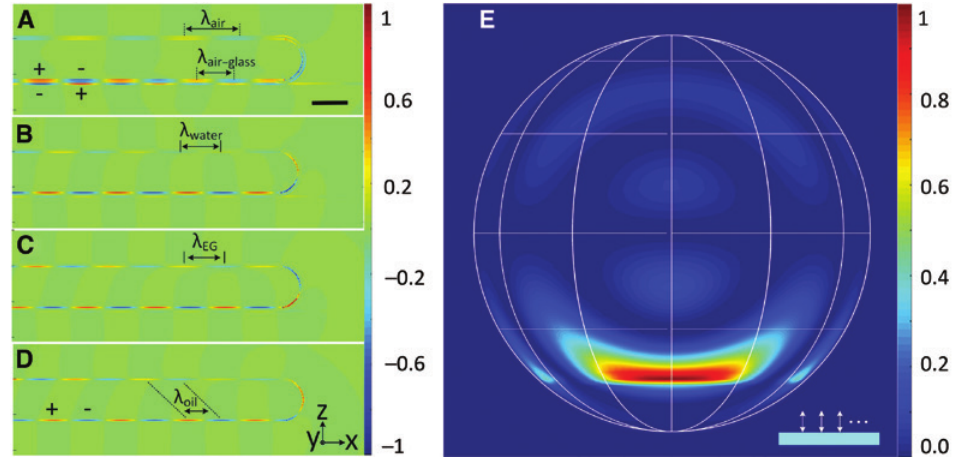
Figure 5: The dipole-chain